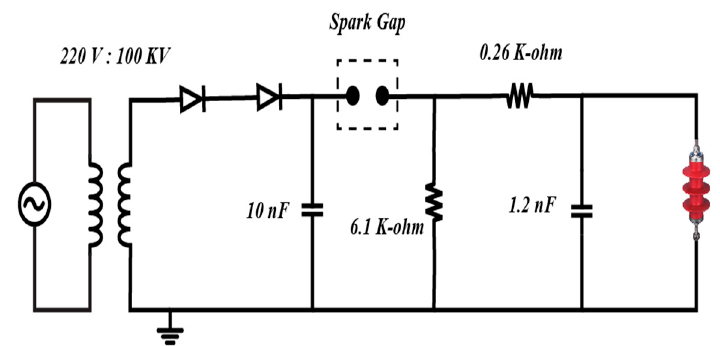
Figure 8. The experimental setup for the lightning impulse voltage test in a